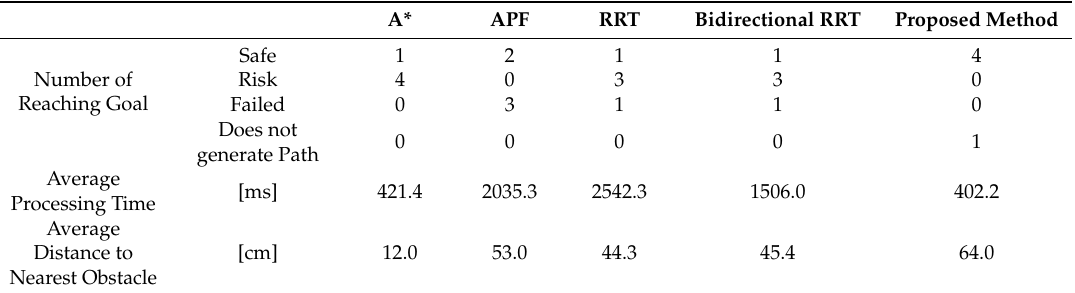
Table 2. A comparison between the proposed method among other methods/algorithms.